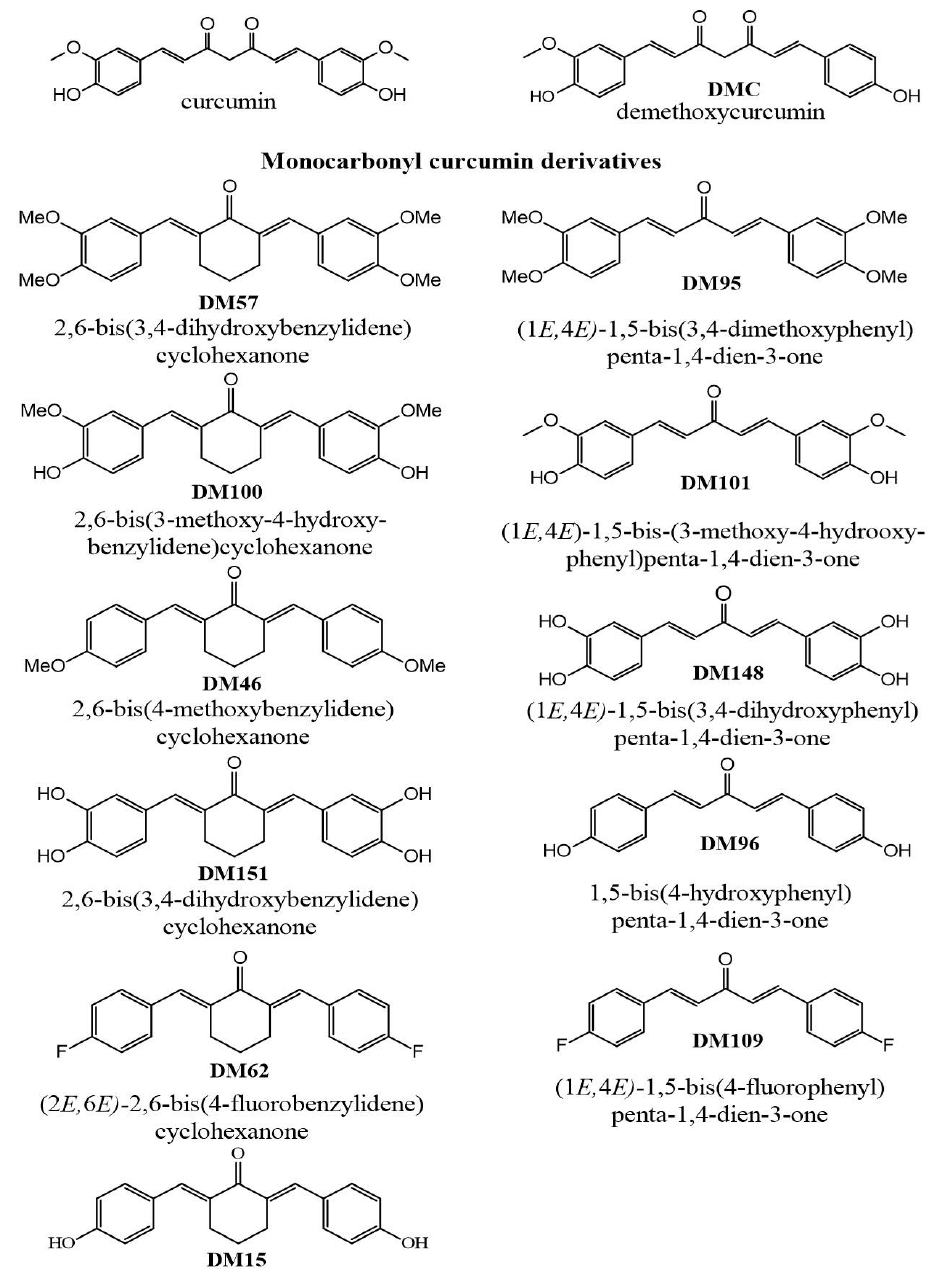
Figure 1. Structures, names, and codes of curcuminoids and of the monocarbonyl curcumin derivatives used in the present study.